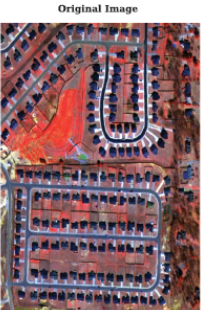
Figure 3. Example of a satellite image obtained with the QuickBird Sensor (RGB – 432)